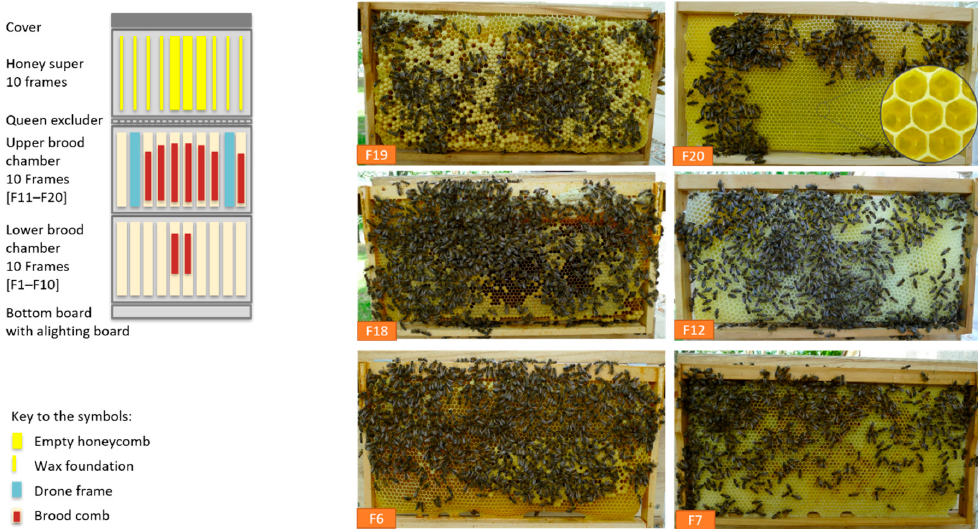
Figure 6. Development of the rehabilitated colony 1 after wintering / hibernation on 28 April 2020 during apple blossom (brood on 9 combs [Zander 477 × 220 mm], honey super empty), F19: capped drone brood, F20 + F7: brood-comb with eggs, F18 + F6: brood-comb with mostly covered worker brood, F12: build up drone brood frame © Ilka